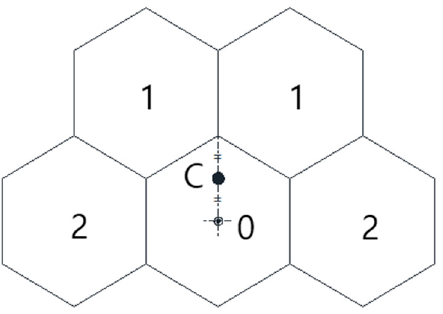
Figure 6. States of each cell in the location area for N =